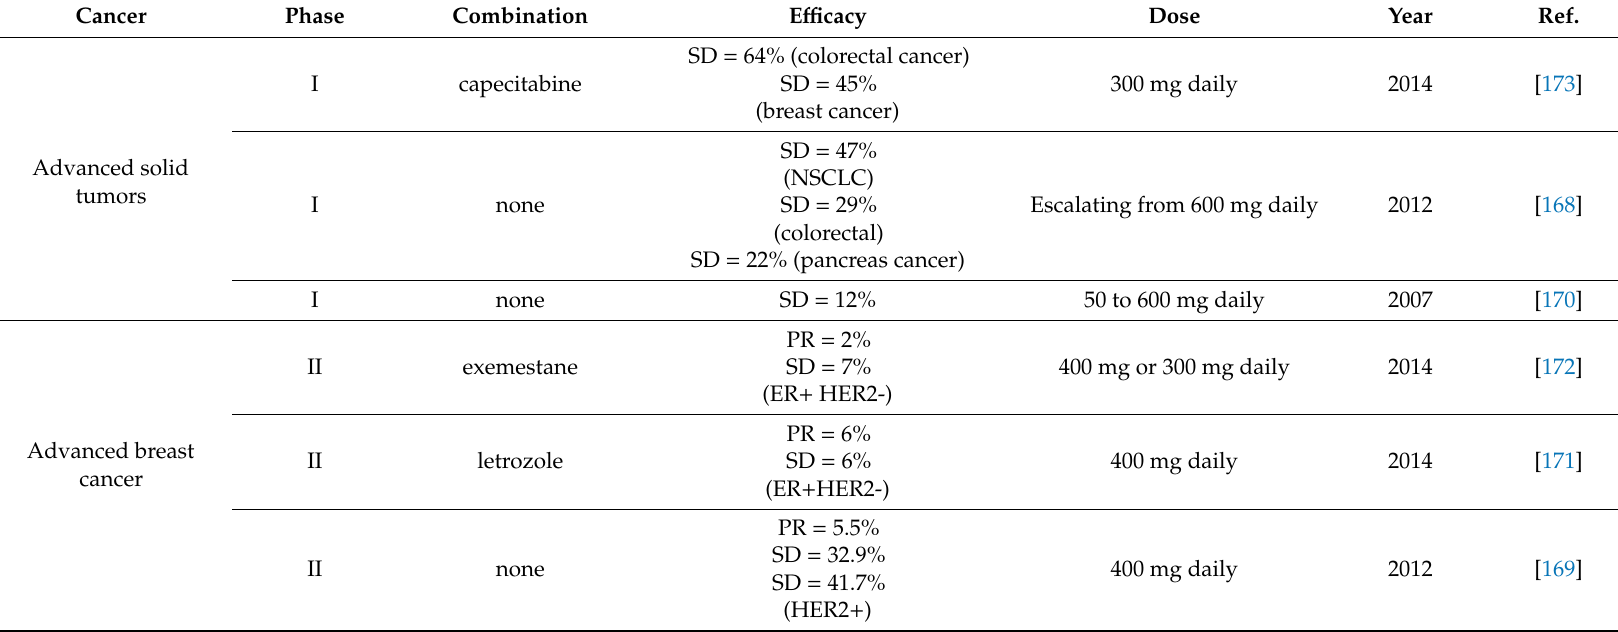
Table 4. Main characteristics of clinical trials designed in advanced solid tumors for the treatment with bosutinib alone or in combination with other drugs. E ffi cacy is to be considered as best clinical response, and when available, the population with the best response is indicated. PR = partial response; SD = stable